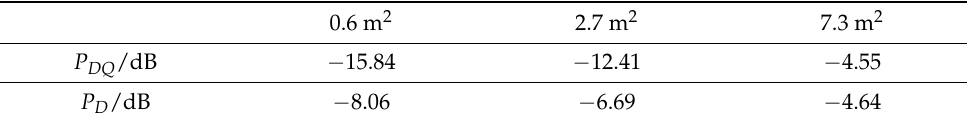
Table 5. Mean of different aperture areas in the 4 π